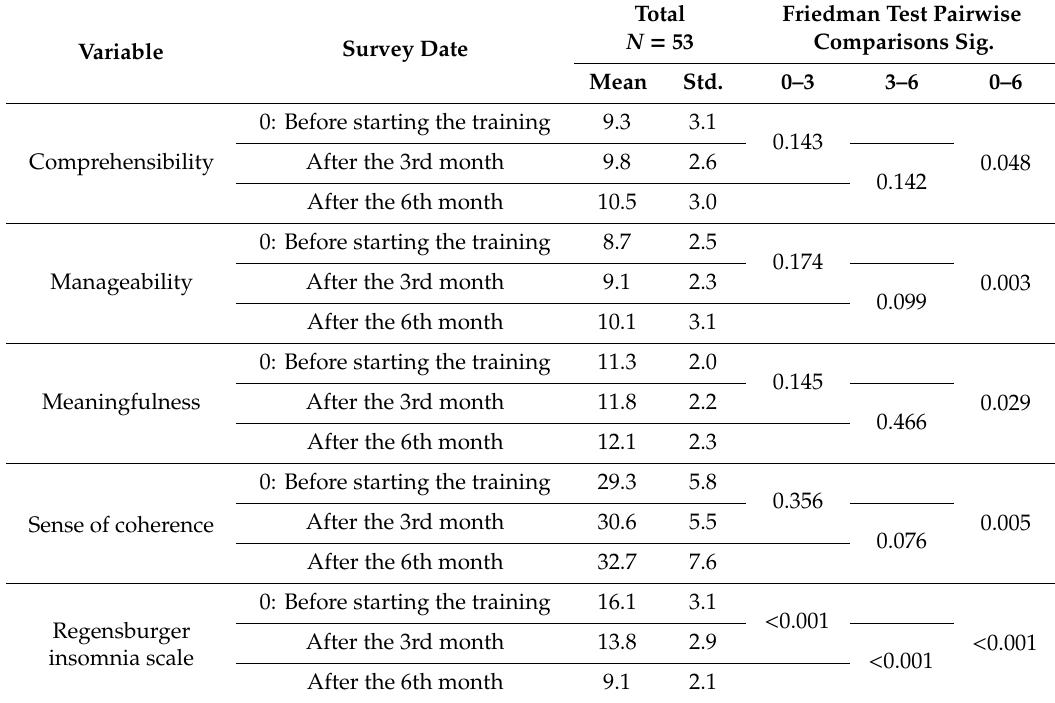
Table 4. Mean and standard deviation of sense of coherence traits, as well as the values measured on the Regensburger scale before starting the training, after three and after six months, as well as the significance levels of the Friedman